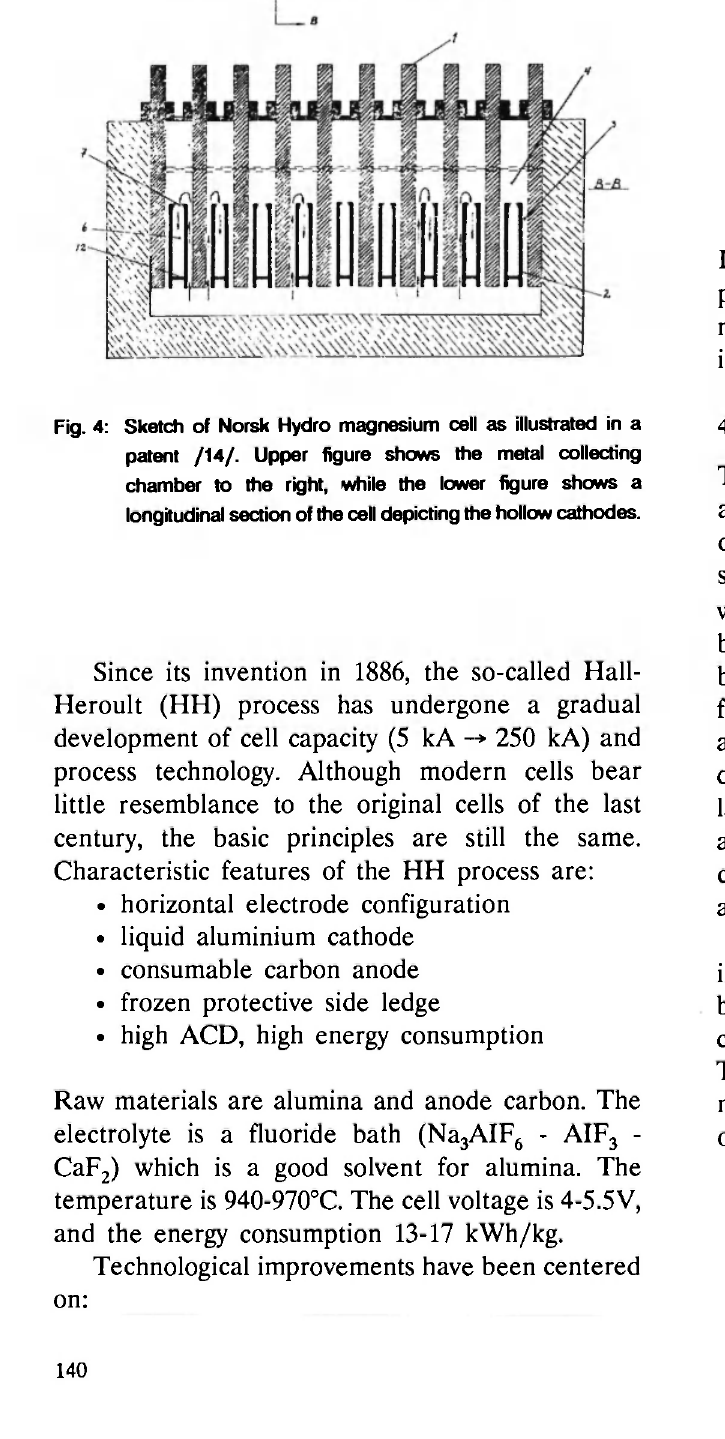
Fig. 5: Principle of gas/metal separation in Alcan magnesium cell